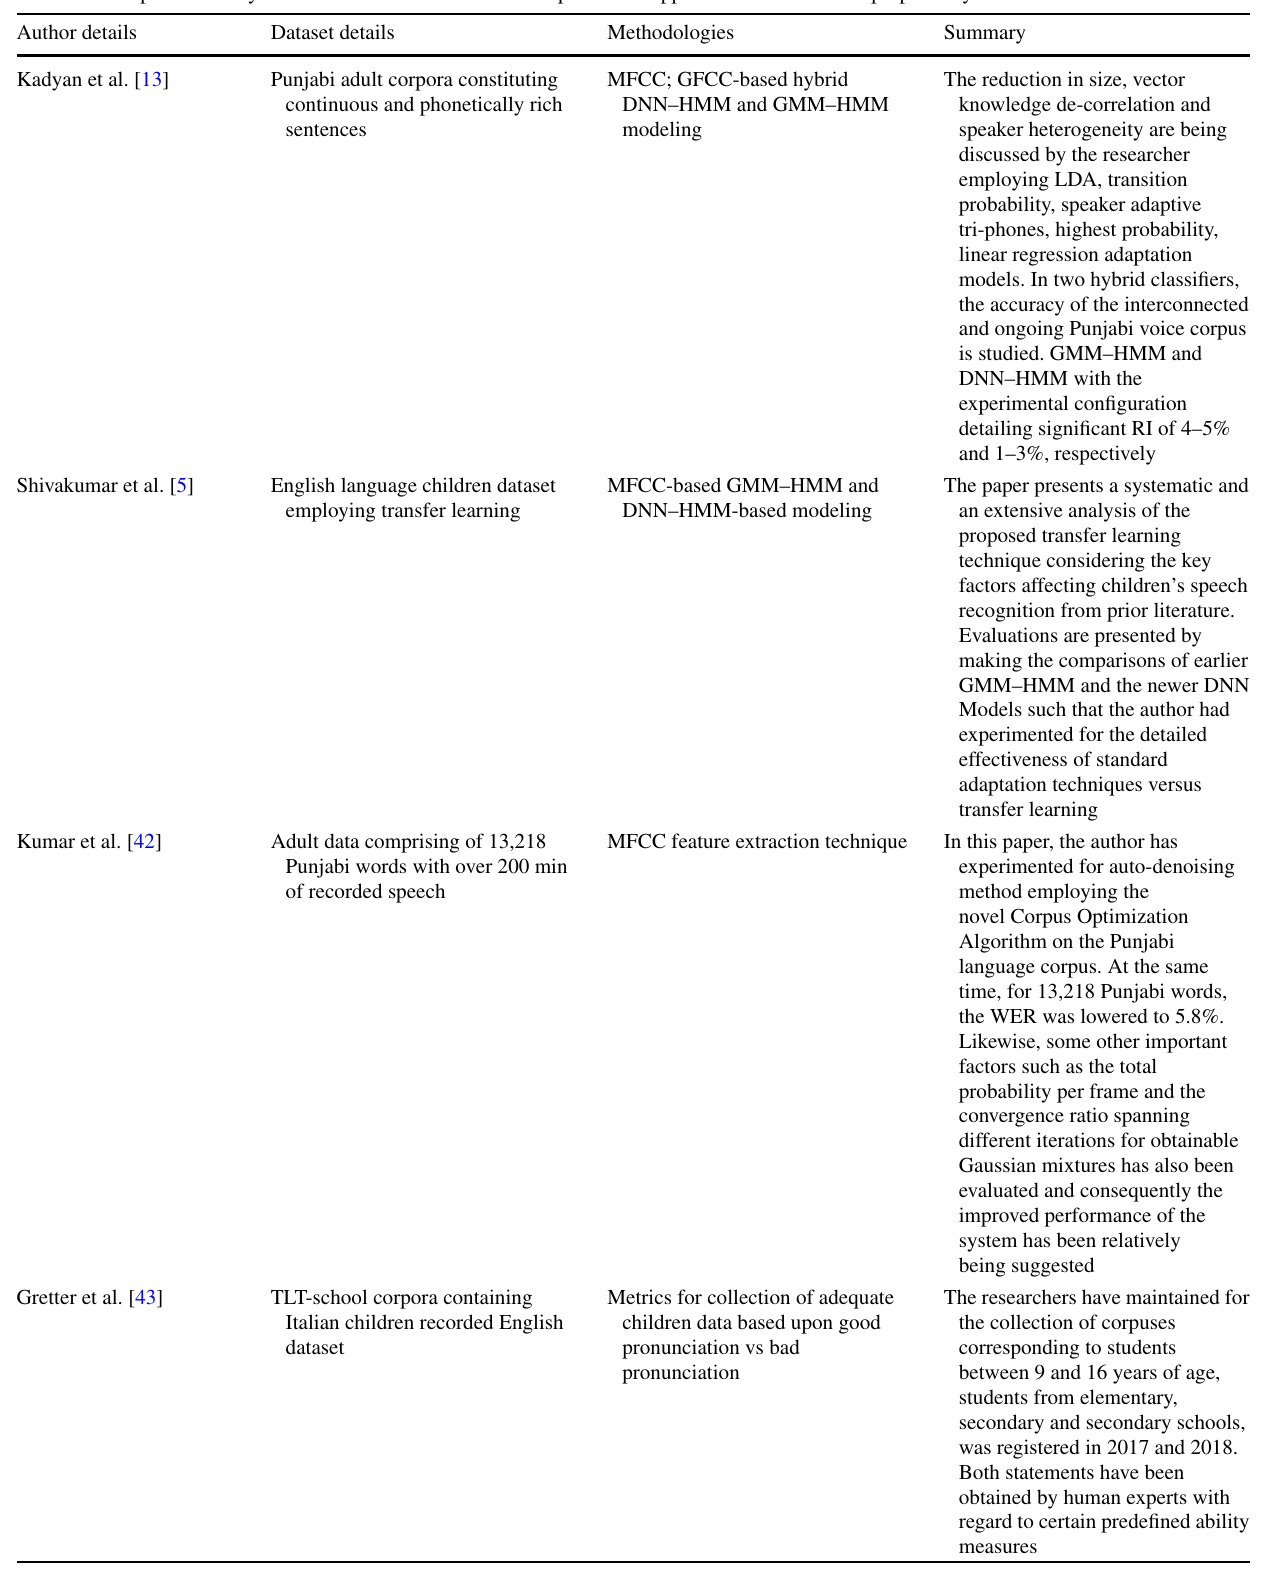
Table 12 Comparative analysis and summarization of earlier implemented approaches in constant to proposed system